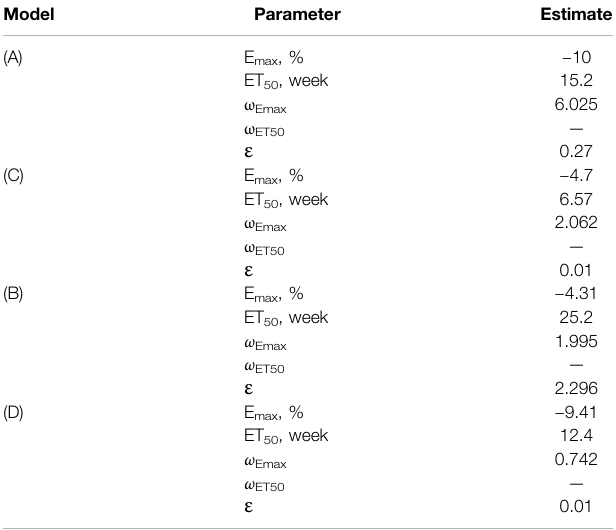
TABLE 2 | Parameter estimates of fi nal